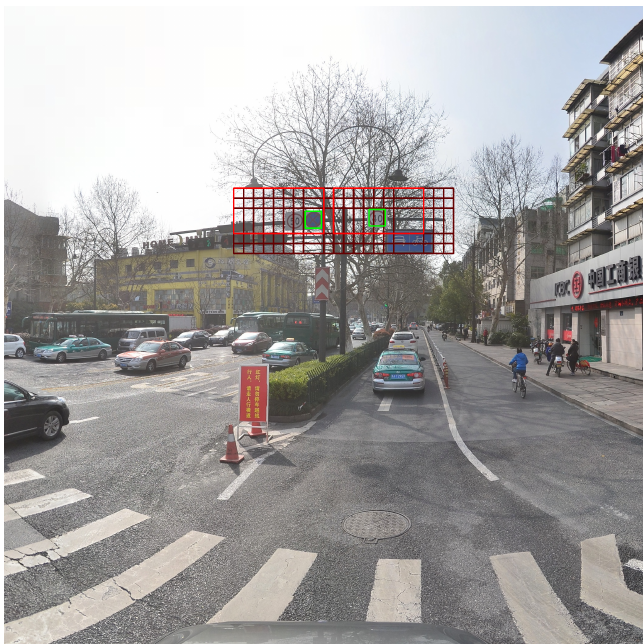
Figure 1. Example of problematic matching in SSD training with TT100K [28]. (Green boxes represent ground-truth objects, red boxes are the default boxes matched to the objects, and dark red boxes are the default boxes with the same IoU as the matched default